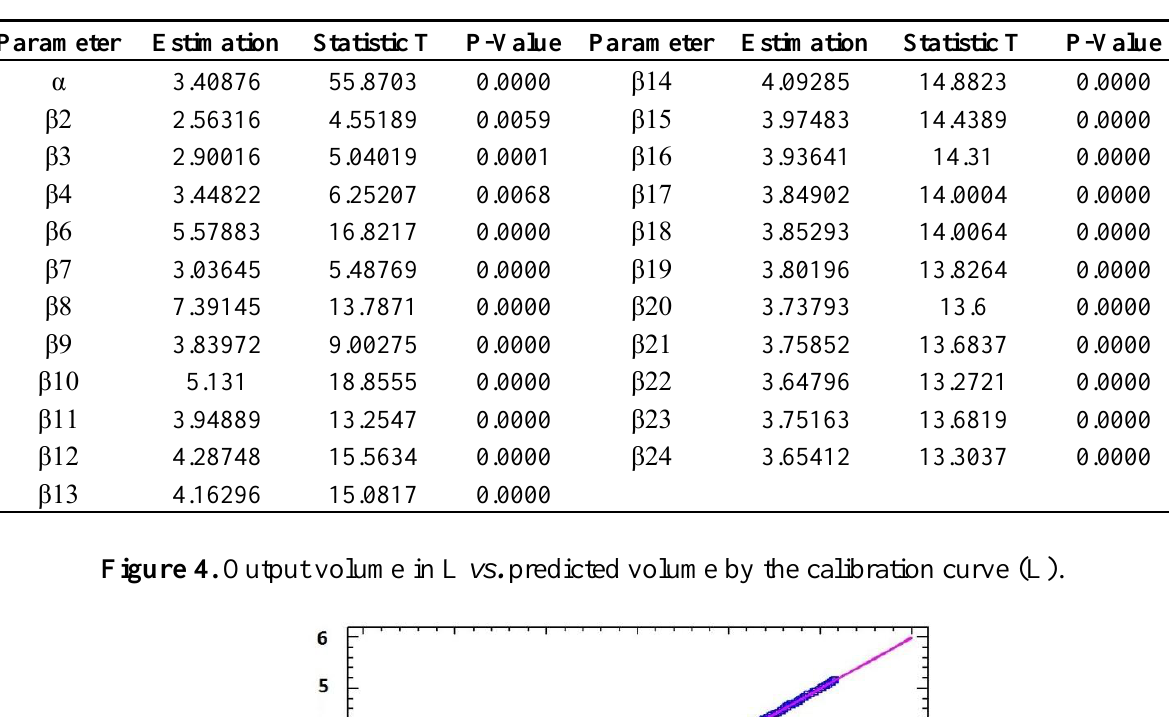
Table 1. Parameter and its estimation (L/10-bit value ( P )) of the significant variables of the multiple linear regression for all P-values that obtained a significance level lower than 0.01.